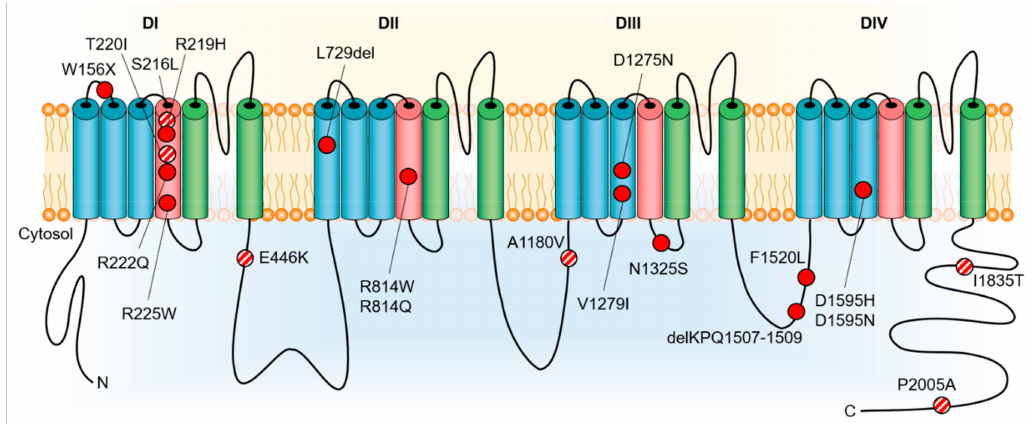
Figure 1. Rare variants in cardiac Na V 1.5 voltage-gated sodium channel ( SCN5A ) reported in association with dilated cardiomyopathy. Two additional variants, c.2550-2551insTG and c.3318dupC, causing truncation of the encoded protein in patients with dilated cardiomyopathy, are not shown. Pathogenic / likely pathogenic variants are shown in red, variants with insu ffi cient evidence of pathogenicity in dilated cardiomyopathy are shown in red /